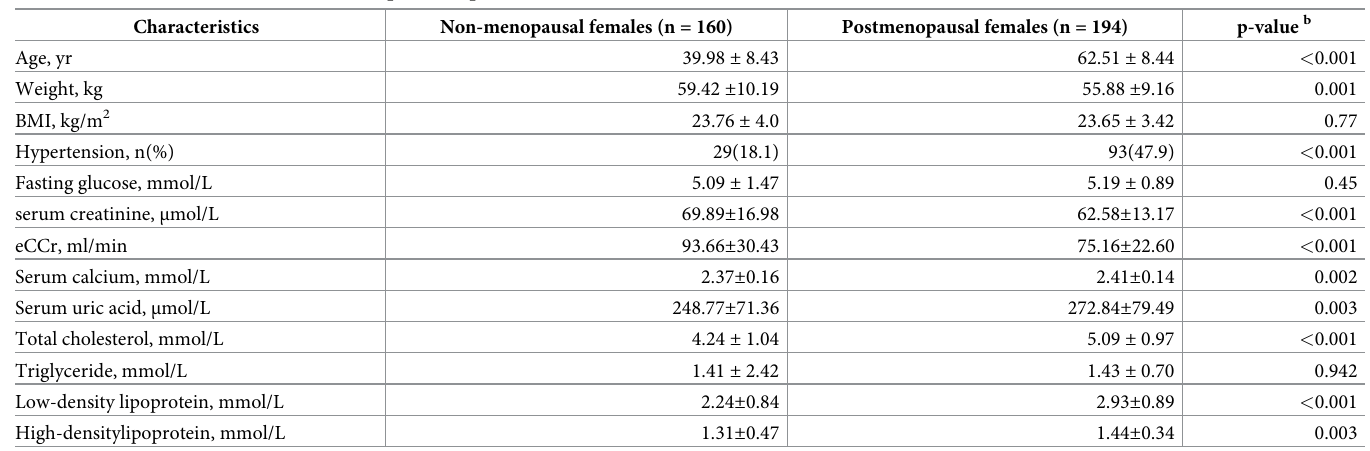
Table 1. Baseline characteristics of non- and postmenopausal women a . Characteristics